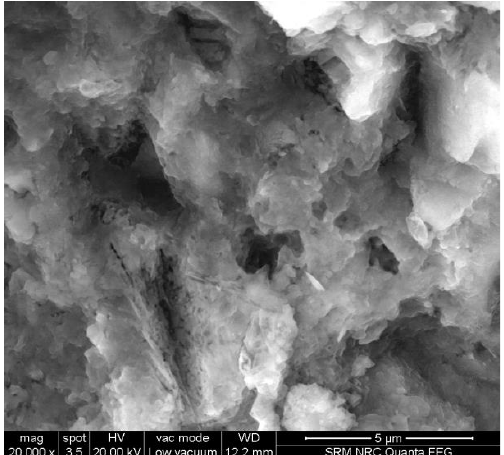
Figure 21. SEM image for controlled concrete.